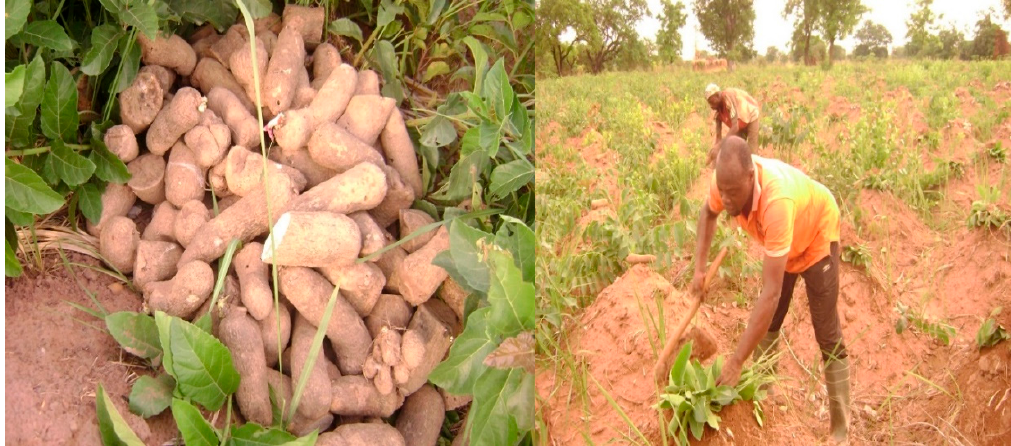
Figure 3. Planting of seed yam at the “Bihigubaani” (BBN) trial site.